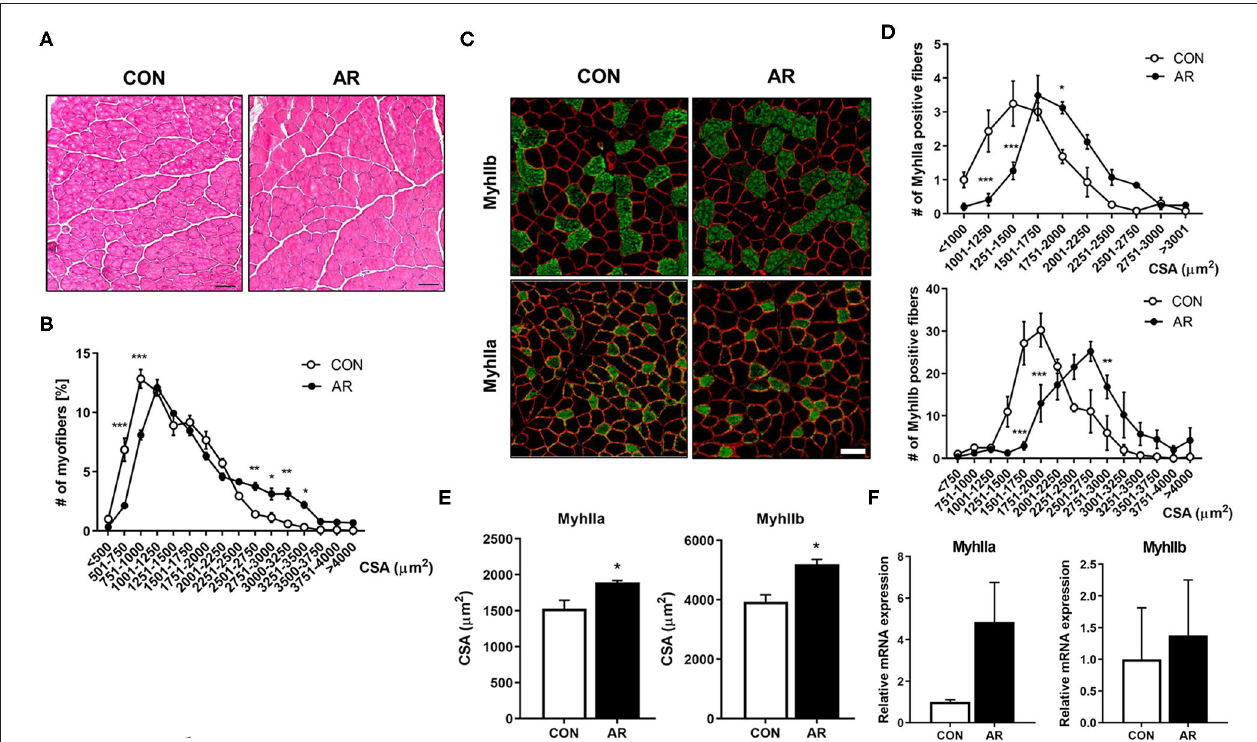
FIGURE 4 | AR induces the formation of larger MyhIIa- and MyhIIb-positive myofibers. (A) Histological staining of TA muscles of 8-month-old mice ingested with control or 3.3 mg/kg AR for 8 weeks. H&E staining shows the structural recovery. Scale bar, 50 µ m. (B) Quantification of the cross-sectional area of total myofibers in TA. (C) Immunostaining of MyhIIb (green), MyhIIa (green), and laminin (red) in the TA muscles of control or 3.3 mg/kg AR-ingested mice for 8 weeks. Scale bar, 50 µ m. (D, E) Quantification of MyhIIb- and MyhIIa-positive myofibers in panel (C) ( n = 3). (F) qRT-PCR analysis for expression of MyhIIa and MyhIIb in the TA muscles of control or 3.3 mg/kg AR-ingested mice for 8 weeks ( n = 3). An unpaired two-tailed student’s t -test. The data represent the mean ± SEM, * P < 0.05, ** P < 0.01 and *** P < 0.001. AR, Aronia extract; TA, tibialis